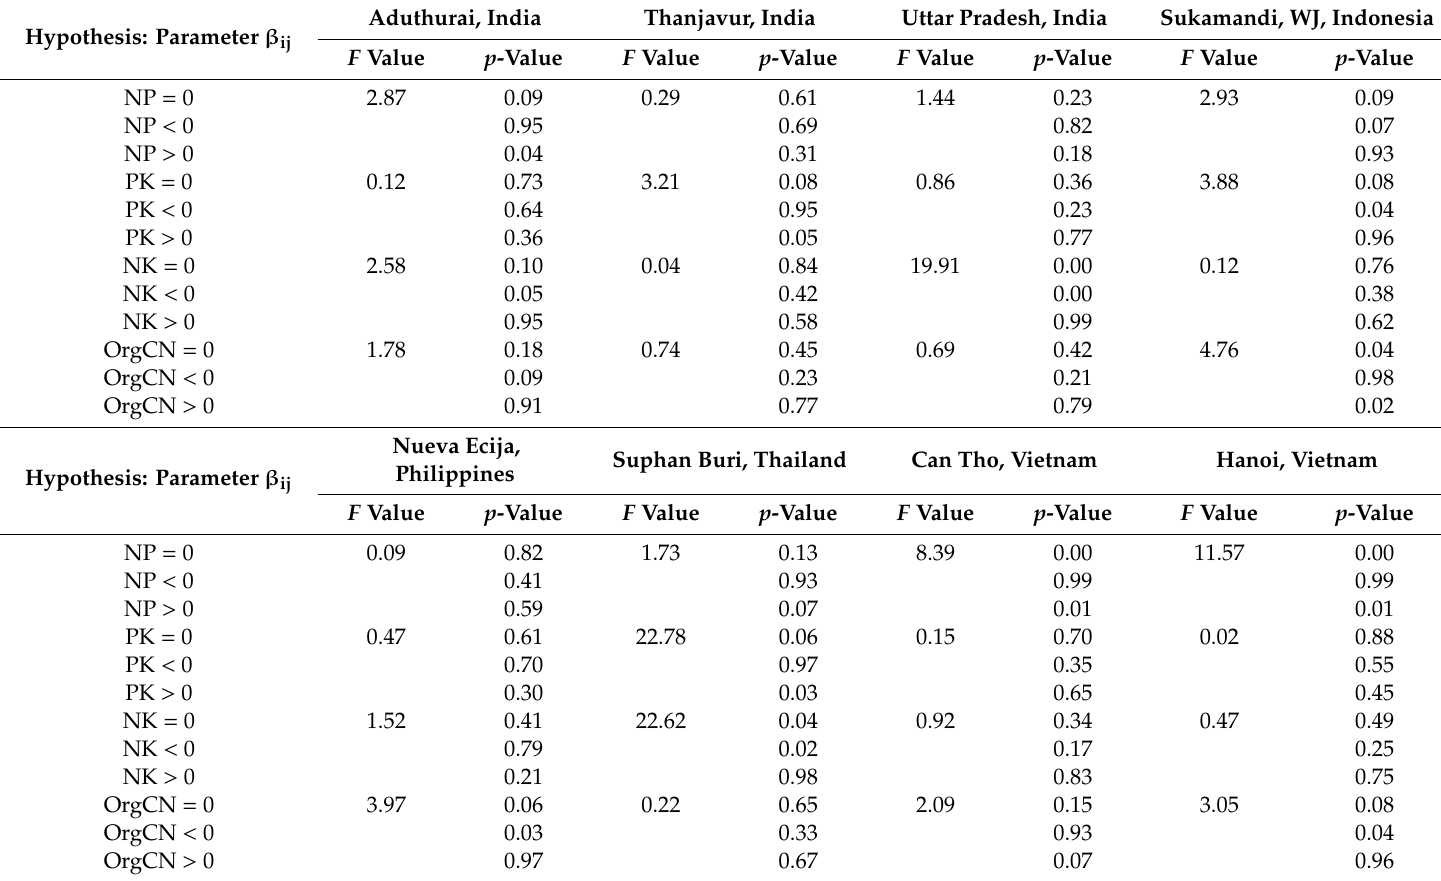
Table 10. Results of hypothesis